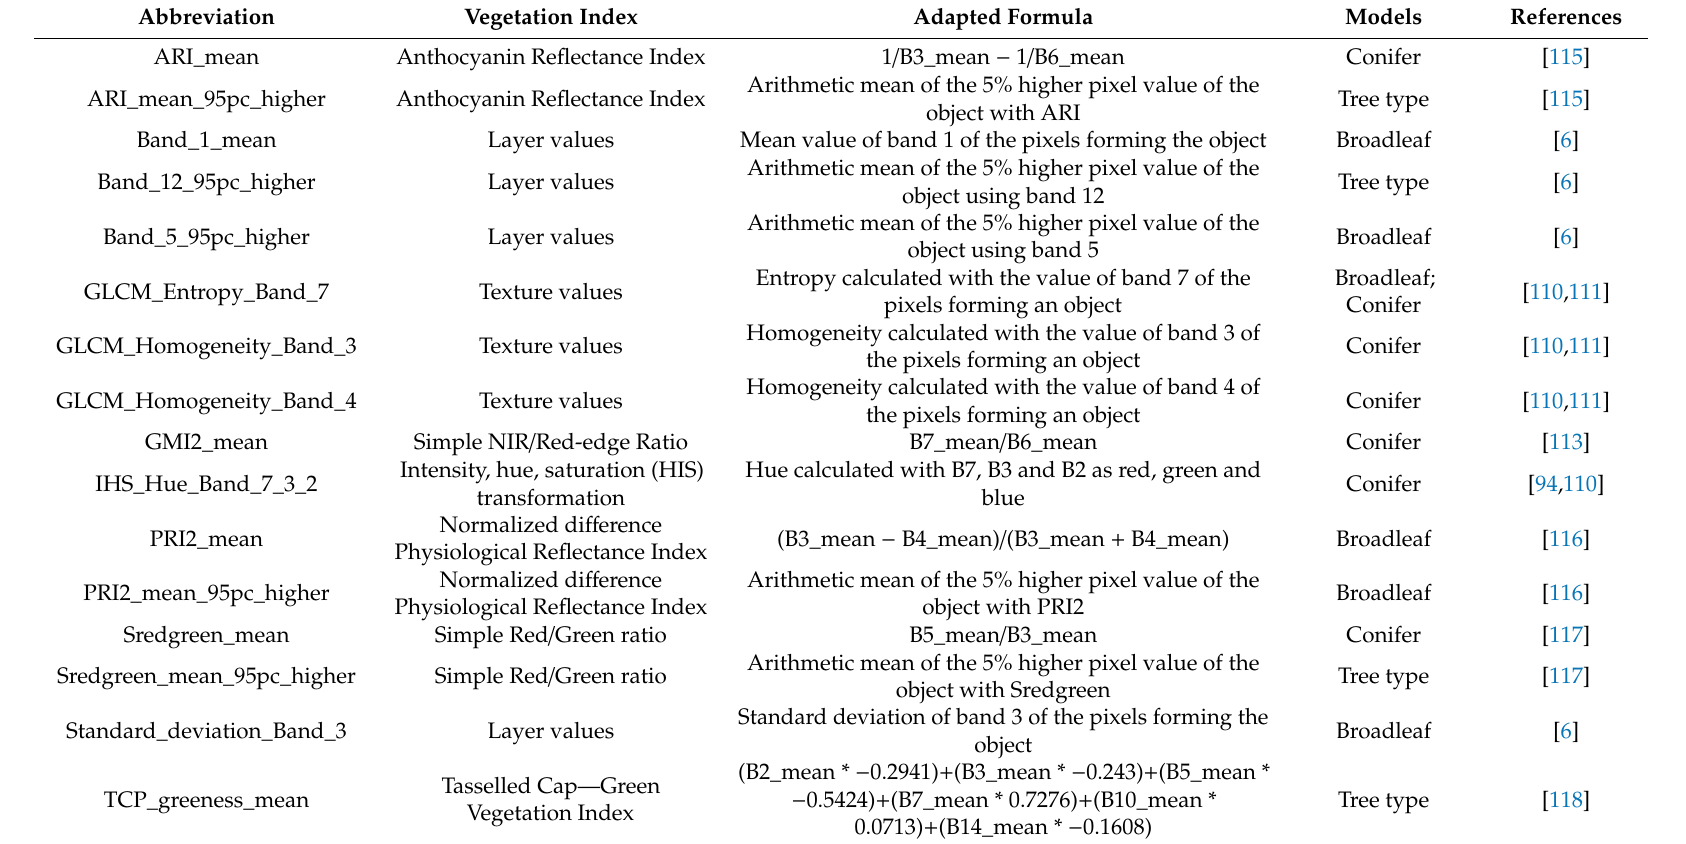
Table 7. Description of the sixteen variables used in the selected models for the hierarchical approach. For spectral indices calculated with 95th percentile highest pixels, the abbreviation is “variable_mean_95pc_higher”, for arithmetic feature calculated for spectral indices, the abbreviation is “variable_mean”. Band numbers are described in Table